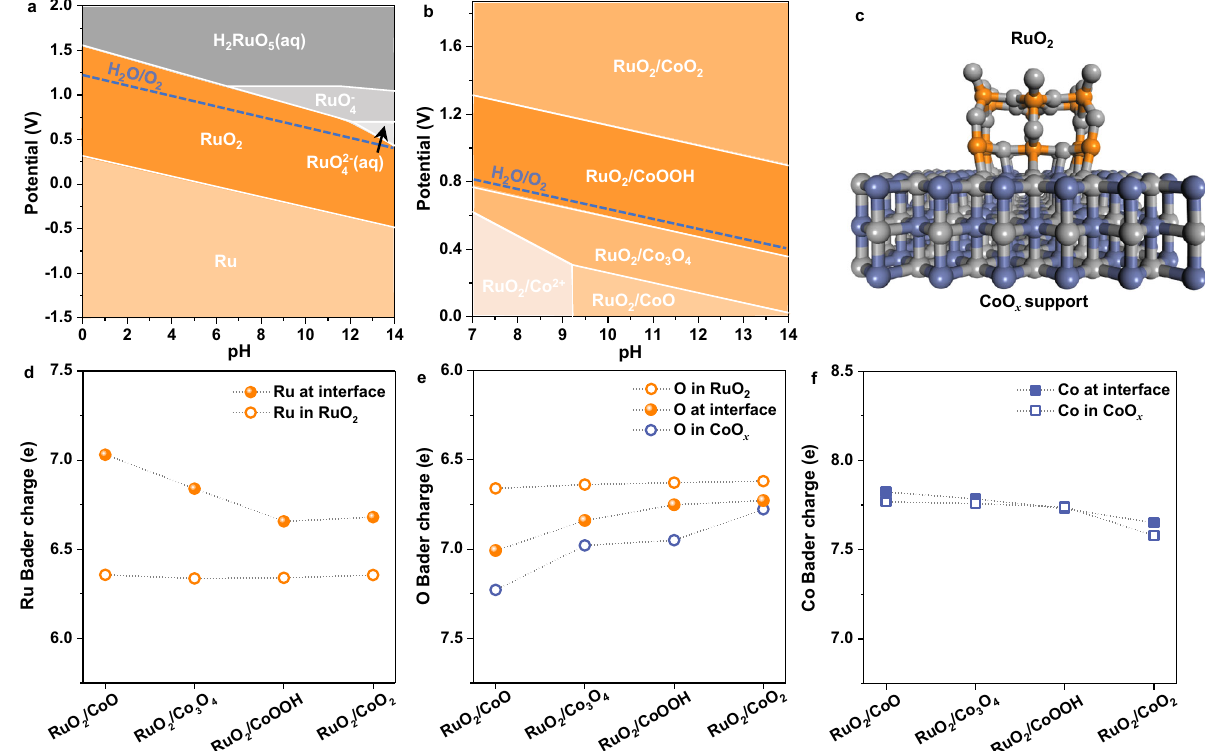
Fig. 1 | Investigation on stability of RuO2 on CoO x support. a , b Calculated Pourbaix diagrams of RuO 2 and RuO 2 /CoO x , respectively. Ion concentrations are 10 − 6 M. The potentials in a and b are referenced to standard hydrogen electrode